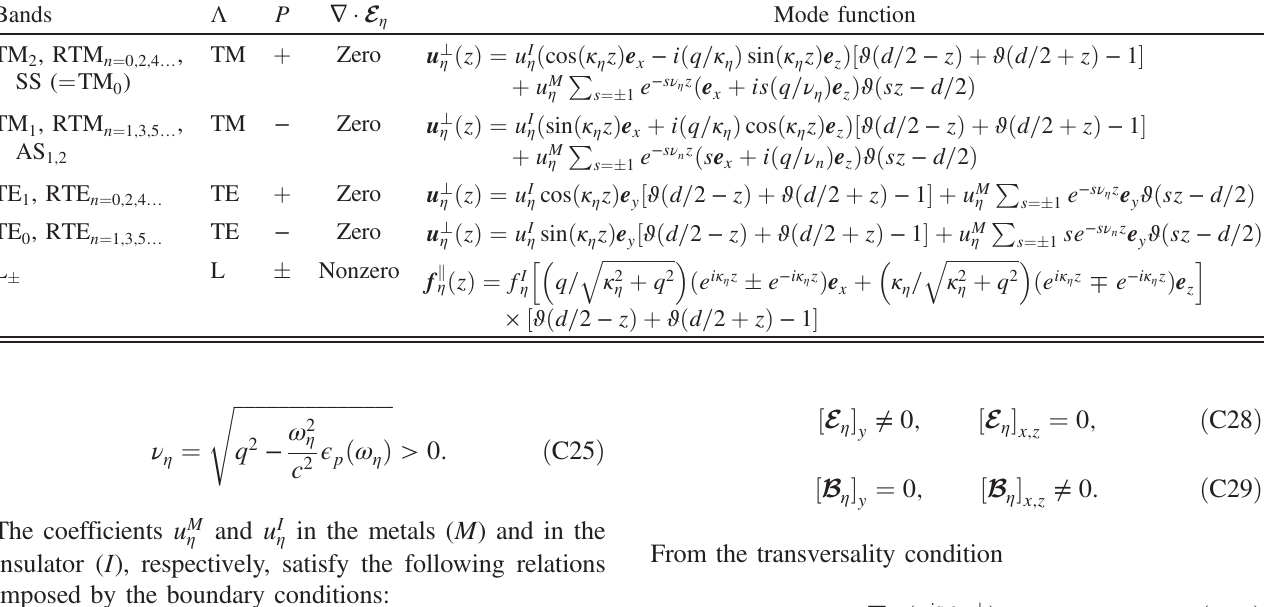
TABLE II. Eigenmodes in the cavity configuration. The labels of the bands are consistent with those shown in Fig. 6. The polarization of each mode is specified by Λ ∈ f TM ; TE ; L g , where TM and TE indicate the transverse magnetic and electric polarizations, respectively, and L denotes the longitudinal polarization. The parity of the mode functions u ⊥ η and f k η are specified by P ¼ (cid:3) (see also the main text). We also indicate whether or not the divergence of the electric field ∇ · E η vanishes. The last column shows the explicit indicates the unit vector in the direction i ¼ x , y , z functional form of the mode function for each eigenmode, where e i